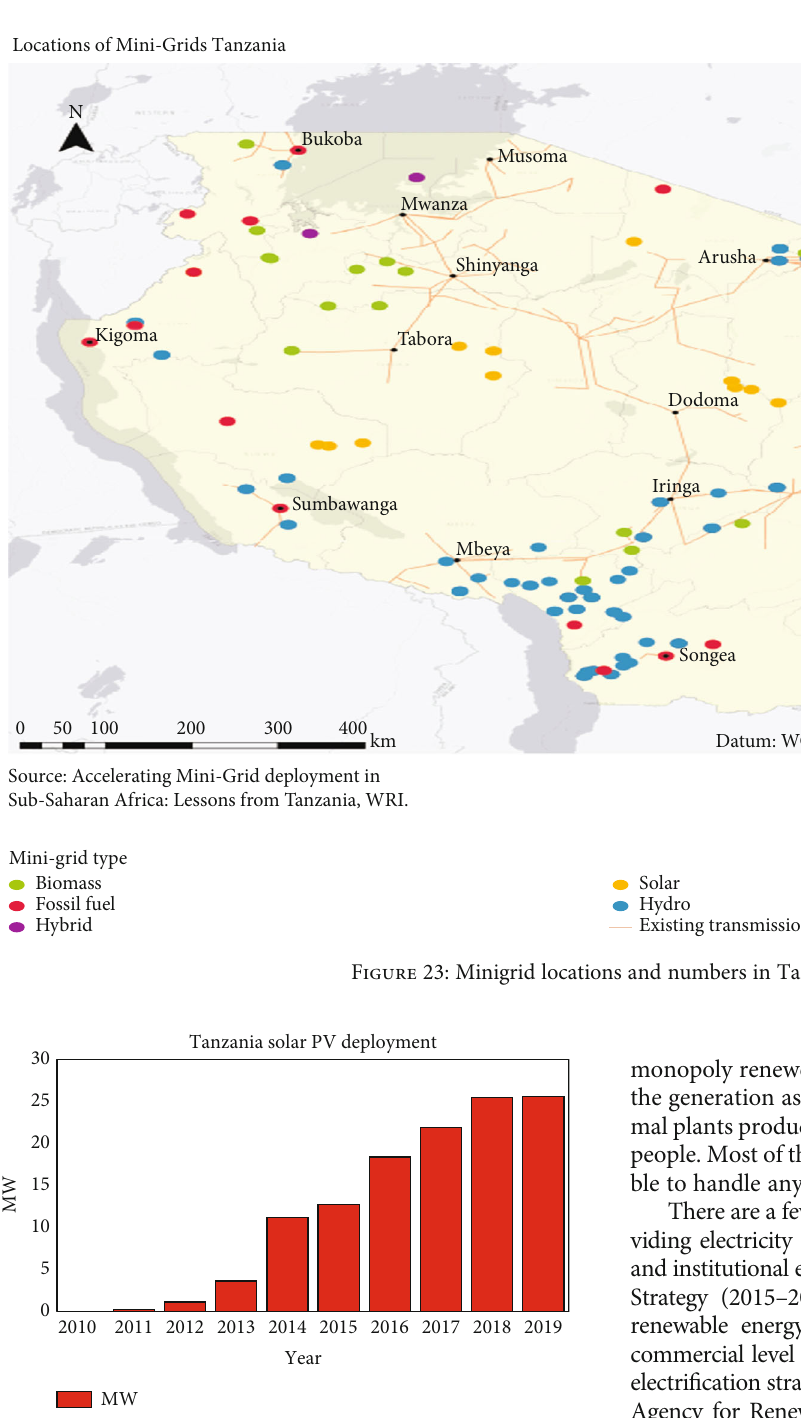
Figure 24: Solar PV trends in Tanzania by